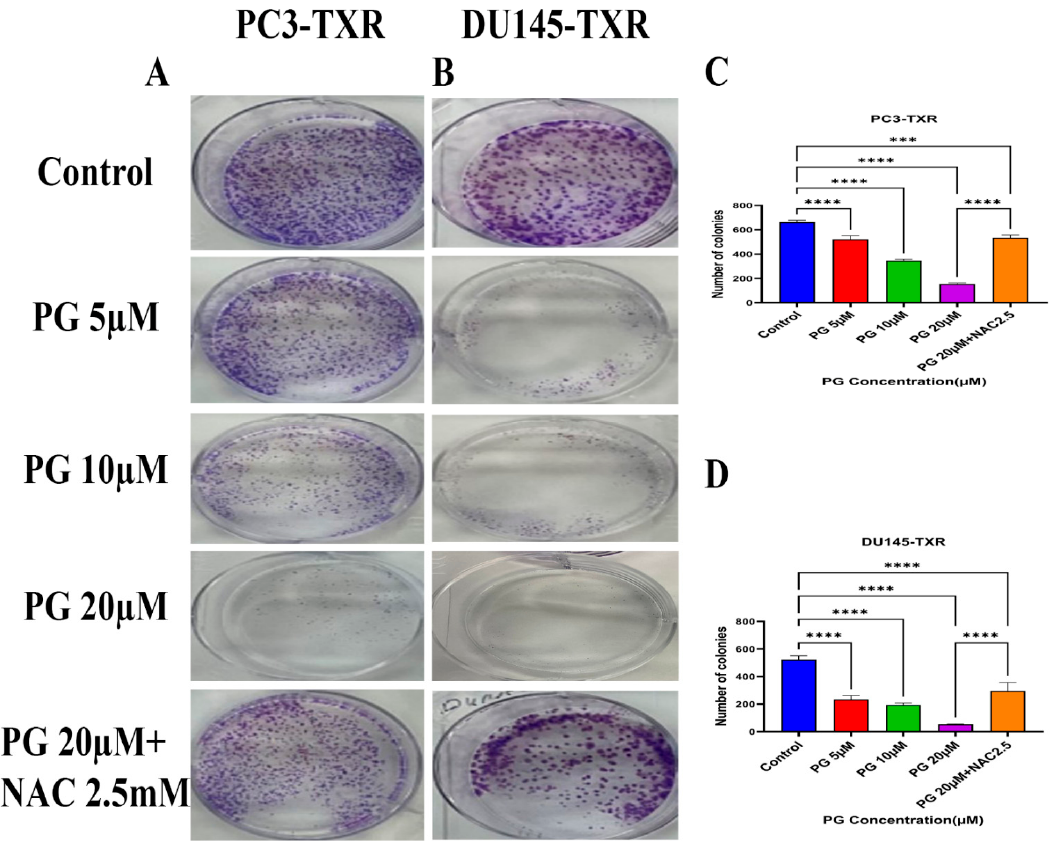
Figure 3. PG inhibits colony formation in taxane-resistant PCa cell lines. ( A ) PC3-TXR and ( B ) DU145-TXR represent images of colony formation after PG treatment. Compared to the control, a substantial decrease in the colonies’ number is observed with PG treatment. ( C ) and ( D ) display the quantified results of the average number of colonies plotted against varying concentrations of PG. Data are represented as mean ± SD ( n = 3) and represent three trials performed in triplicate independently. *** p < 0.01, and **** p < 0.001.